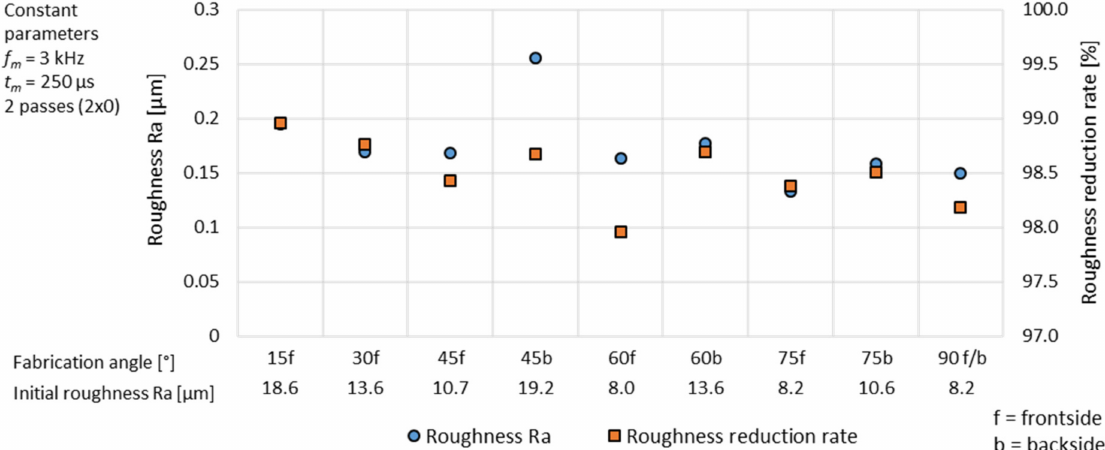
Figure 26. Achievable roughness Ra and relative roughness reduction rate depending on the fabrication angle with f m = 3 kHz, t m = 250 µ s and two polishing passes (2 × 0).